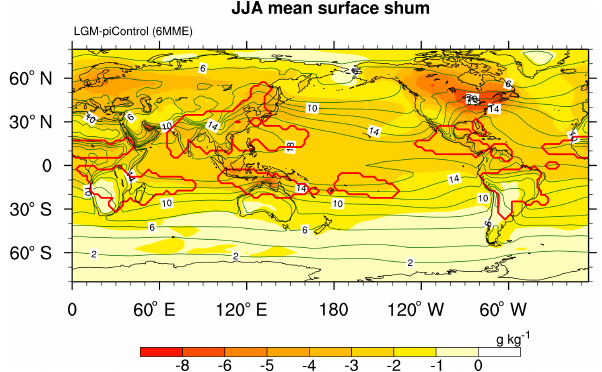
Figure 2. Difference of JJA mean surface specific humidity be- tween LGME and piControl (shaded). The green contours denote the climatology derived from piControl. The red lines enclose the monsoon domains. Only those areas where the signal-to-noise ratio exceeds 1 are plotted.